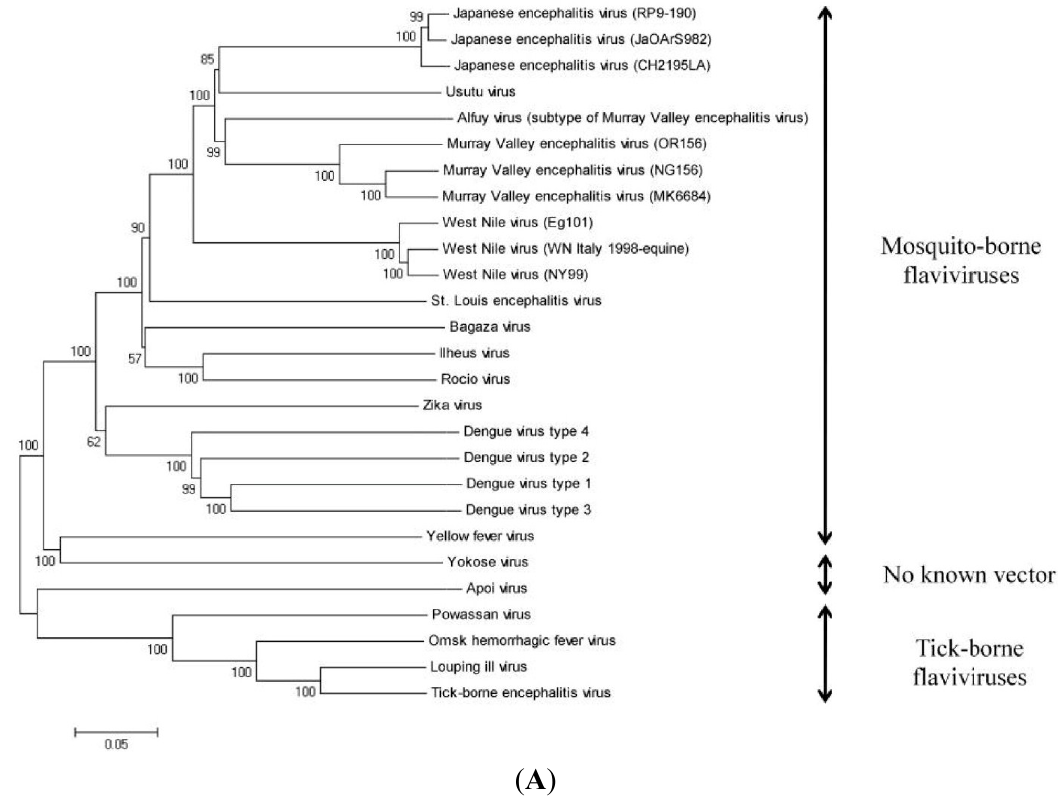
Figure 2. USUV model, its gene structure, and the proteins encoded by its genome. The polyprotein precursor is cleaved by cellular and viral proteases to yield three structural proteins (C, prM, and E) and eight non-structural proteins (NS1, NS2A, NS2B, NS3, NS4A, 2K, NS4B, and